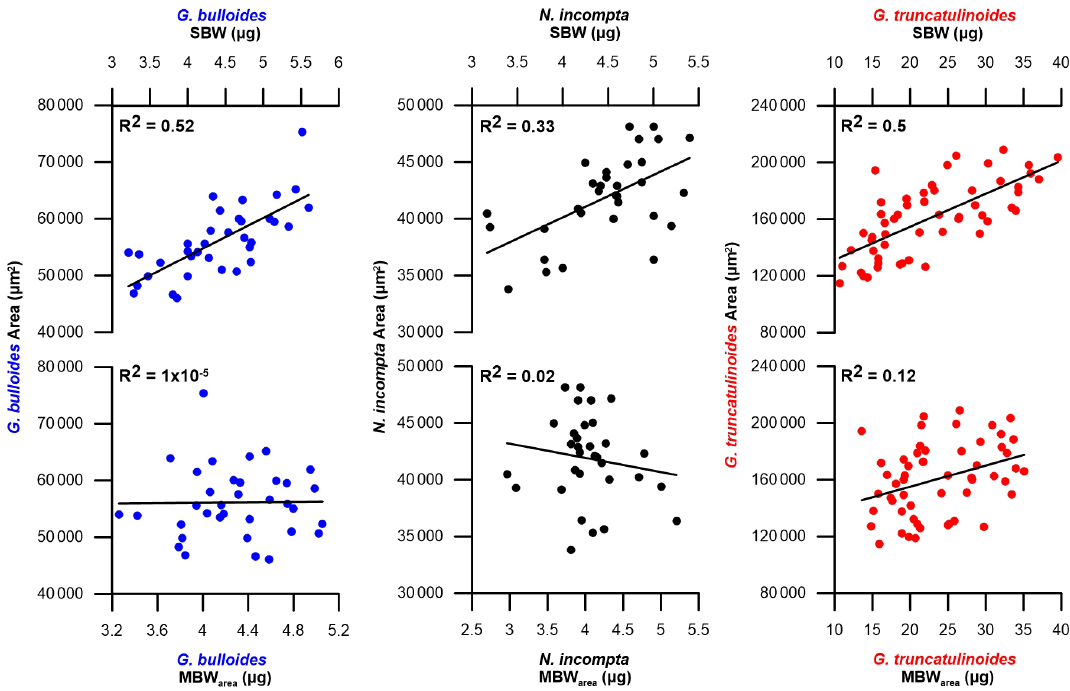
Figure 2. SBW in µg and MBW area in µg against the mean test area in µm 2 for foraminifera samples in the Planier sediment trap. Dark blue dots correspond to G. bulloides , black dots to N. incompta , and red dots to G. truncatulinoides . Table 3. Pearson correlation test results for the three species’ correlation between area (µm 2 ) and both SBW (µg) and MBW area (µg). Here ci stands for “confidence interval”. Significant r values (0 < ci < 1) are set in bold. Area (µm 2